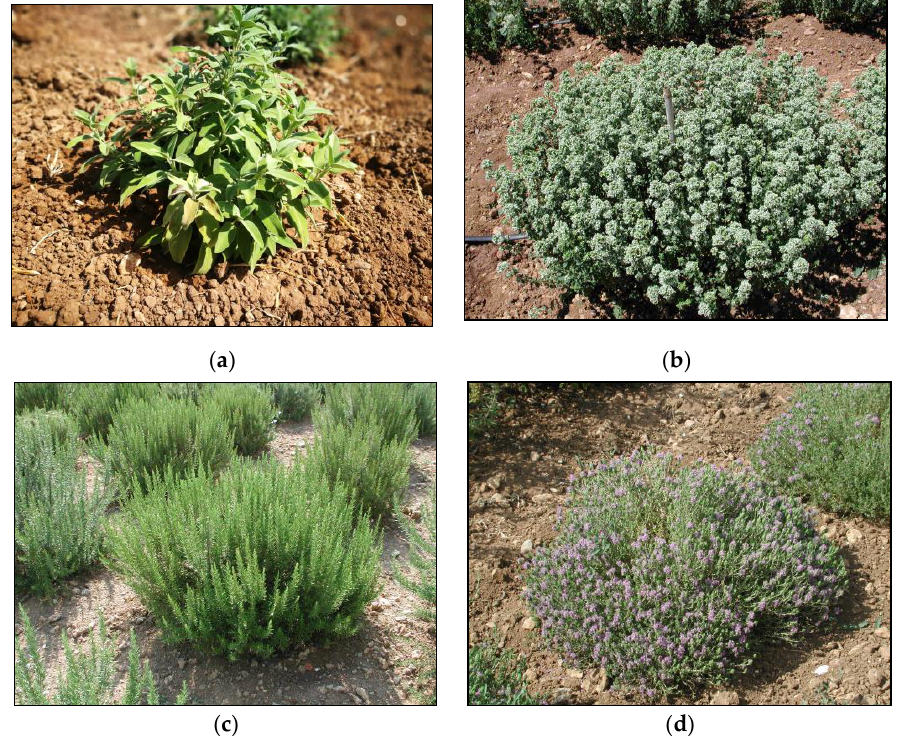
Figure 1. Accessions of medicinal and aromatic plants (MAPs) grown in the collection fields. ( a ) refers to common sage, ( b ) referes to oregano, ( c ) refers to rosemary and ( d ) refers to thyme plants. Common sage and rosemary were planted at 2 m × 1 m spacing while oregano and thyme at 1.5 m × 1 m spacing. The accessions had previously been collected in various Sicilian areas which were different for soil and climate conditions. Plants were 4 years old. Each collection field was equipped with a drip irrigation system. However, plants were grown in dry conditions, this being a traditional practice used for cultivation of MAPs in Sicily. Plants exploited the residual soil fertility and no chemical fertilization application was given during the year. Weed control was manual and no pesticides were used. Harvest was carried out when most plants of the 4 species were at the full blooming stage. 2.3. Morphological and Production Parameters Morphological and production measurements were made on a sample plot of 10 plants per accession, excluding the border rows. The main morphological parameters (data not shown) of each species, such as plant height, number of branches, number of stems, floral spike length, flowers length and width were recorded. The plant fresh weight of above and below-ground plant parts was determined by harvesting the plants. The harvested plant material was, subsequently, dried in an oven at 65°C for 48 h. The plant dry weight was, then, calculated. Dry matter yield per hectare was also estimated. Samples of leaves and flowers were collected from the accessions of each species when 80% of the plants were in full flowering stage. These samples were, subsequently, hydrodistilled for 2 h in a Clevenger-type apparatus with a separated extraction chamber. EOs obtained were dried over anhydrous sodium sulphate and stored in dark flask at − 18°C in freezer until the EO samples were analysed by gas – liquid chromatography (GC) and mass spectrometry (MS) or used in the studies. EO yield was calculated by multiply- ing dry matter yield by oil content, by 0.90 (approximate specific gravity of oil) [20 – 22]. Finally, for each accession within the 4 species, the EO content was related to dry weight in order to select the most promising accessions. 2.4. Chemicals Potassium hydroxide and solvents were purchased from Sigma Aldrich (Steinhem, Germany) (analytical grade) hexanal. (E)-2-hexenal and 2-methyl-pentanol were pur- chased from Sigma (Steinhem, Germany). Activated charcoal (0.50 – 1.00 mm; 18 – 35 mesh ASTM) was purchased from E. Merck (Schuchardt, Germany). The charcoal was cleaned by treatment in a Soxhlet apparatus with diethyl ether and was tested in order to verify the absence of any absorbed substances. 2.5. GC-MS Analyses of EOs